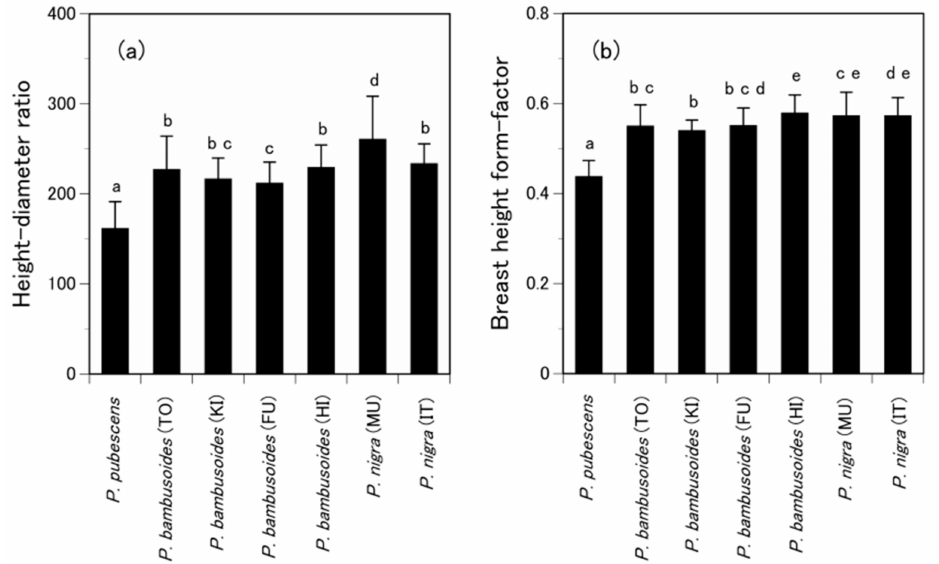
Figure 7. Comparisons of ( a ) height-diameter ratio and ( b ) breast height form-factor for each species and site. Error bars indicate the standard deviation. Values labeled with the same lower case letter are not significantly different according to Tukey’s HSD